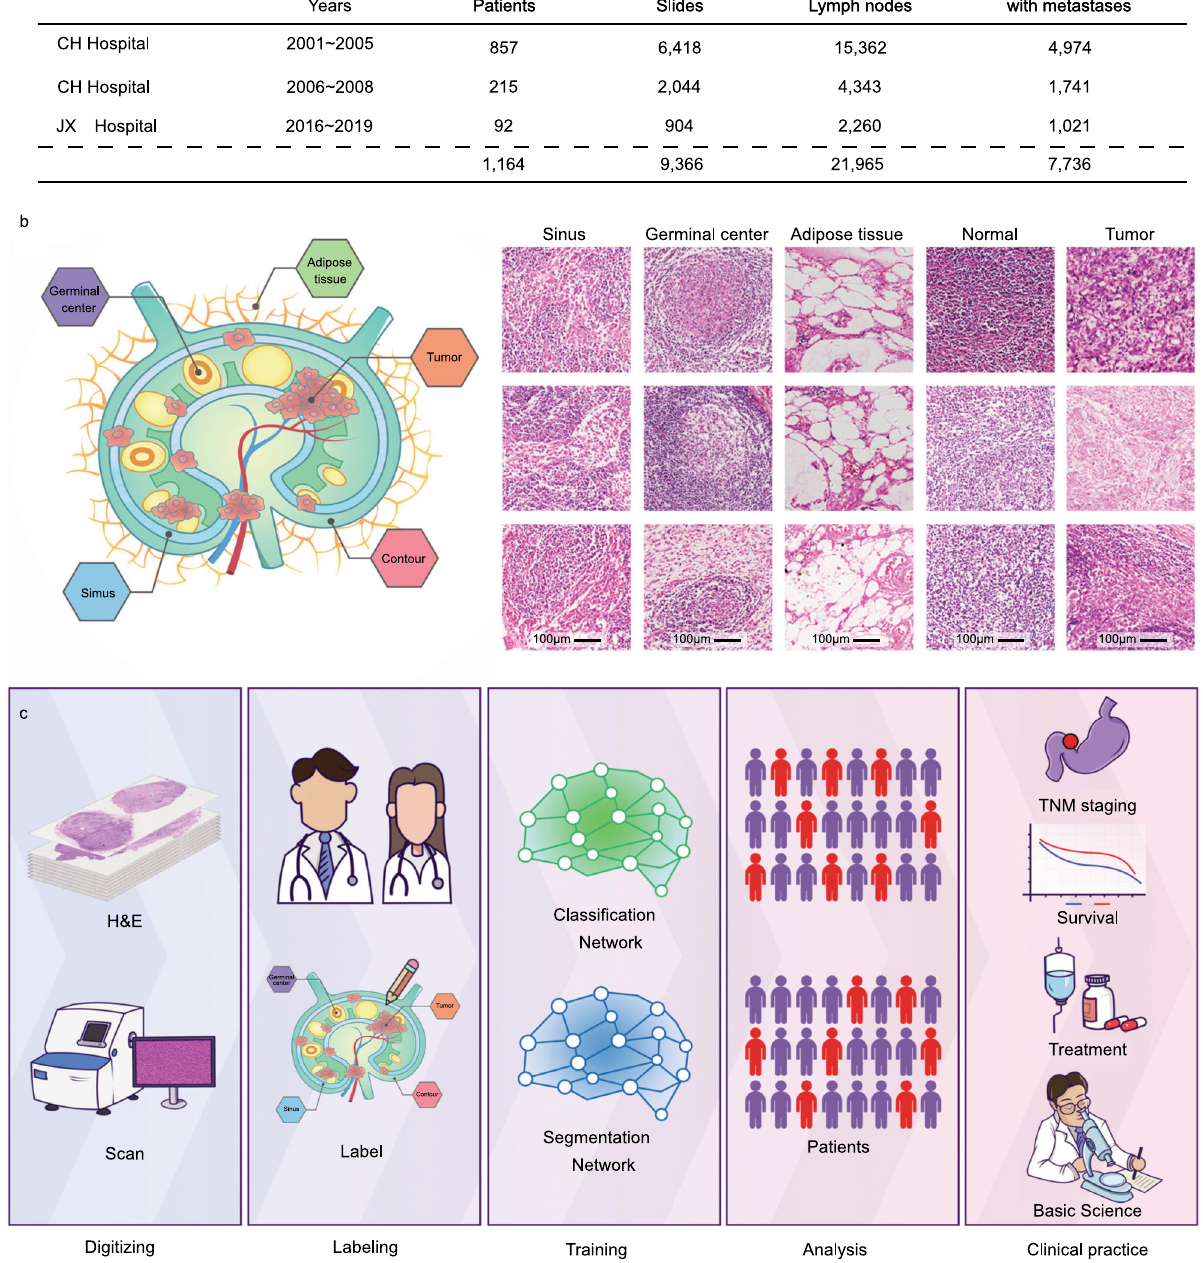
Fig. 1 Data and work fl ow for analysis of cancer lymph node metastasis with deep learning. a Summary of each dataset. b Representative images for each of the fi ve tissue classes we labeled in the lymph node area. c H&E pathological slides were fi rst scanned to obtain WSIs. The WSIs were then labeled for training networks. The trained networks were used to analyze the patient ’ s WSIs and applied to clinical